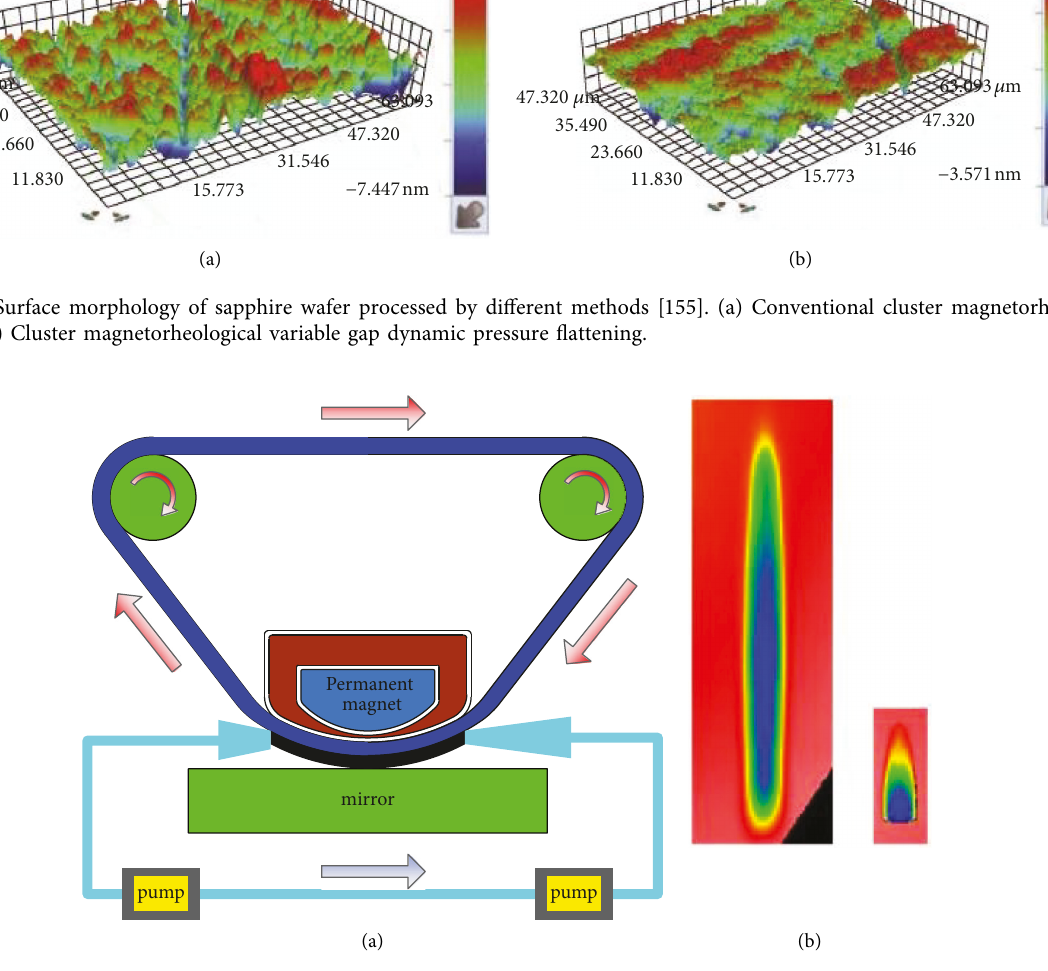
Figure 29: (a) Belt-MRF principle; (b) the removal function comparison between belt-MRF and the existing wheel-type MRF [157, 158].